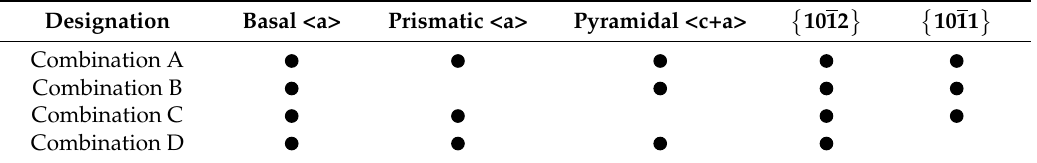
Table 2. Combinations of deformation mechanisms used in VPSC modeling. (Symbol indicates the involved deformation